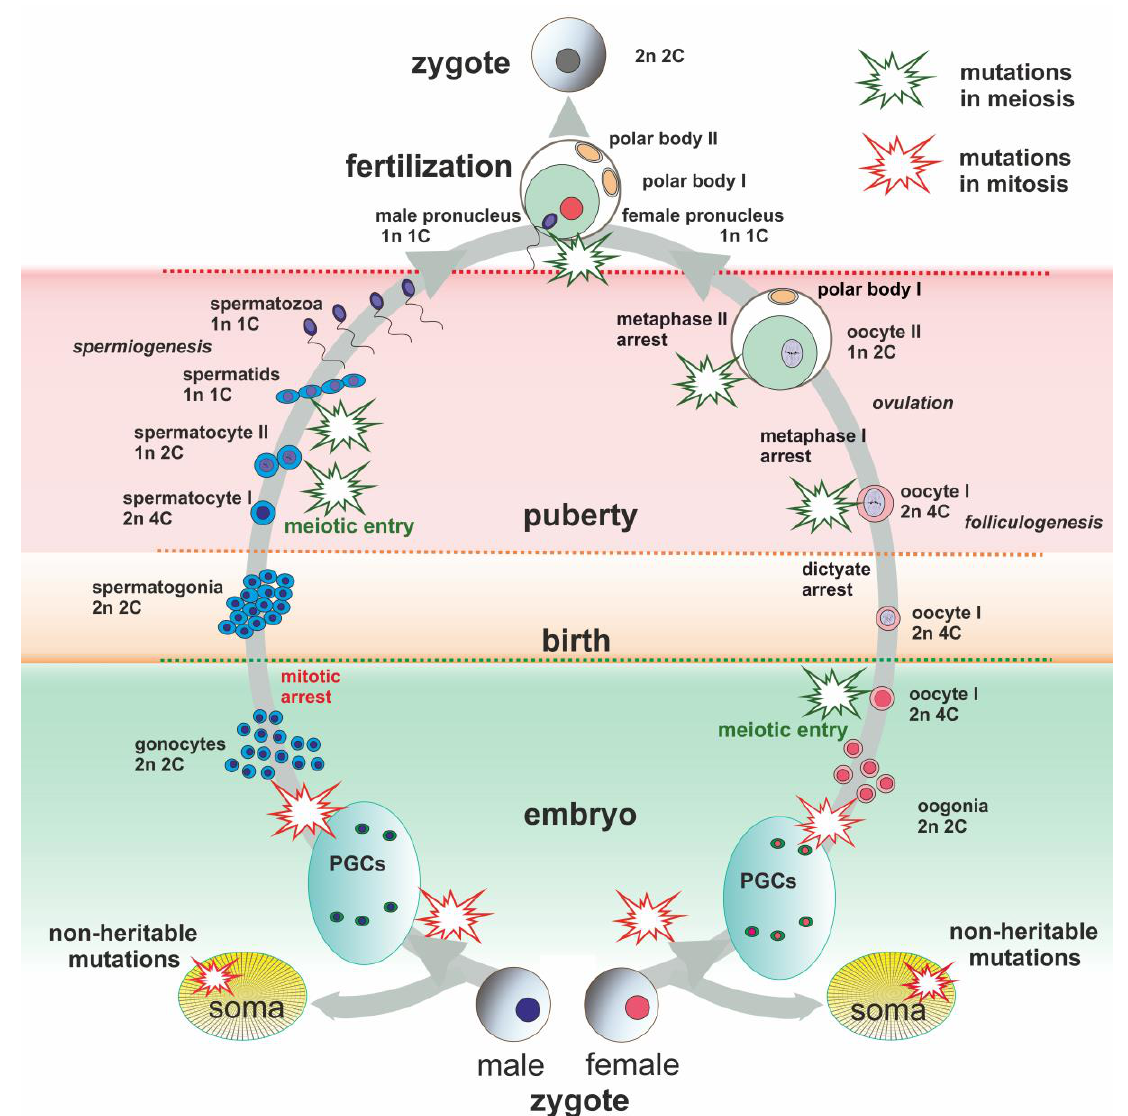
Figure 1. Schematic presentation of main events of male and female lifespan. Evolutionarily signif- icant de novo chromosome rearrangements might occur during the lifespan and be transmitted to descendants. Somatic mutations are not inherited unless they can lead to the same type of chromo- some rearrangements. Schematic explosions mark points of possible heritable mutations (green for meiotic origin and red for mitotic origin).